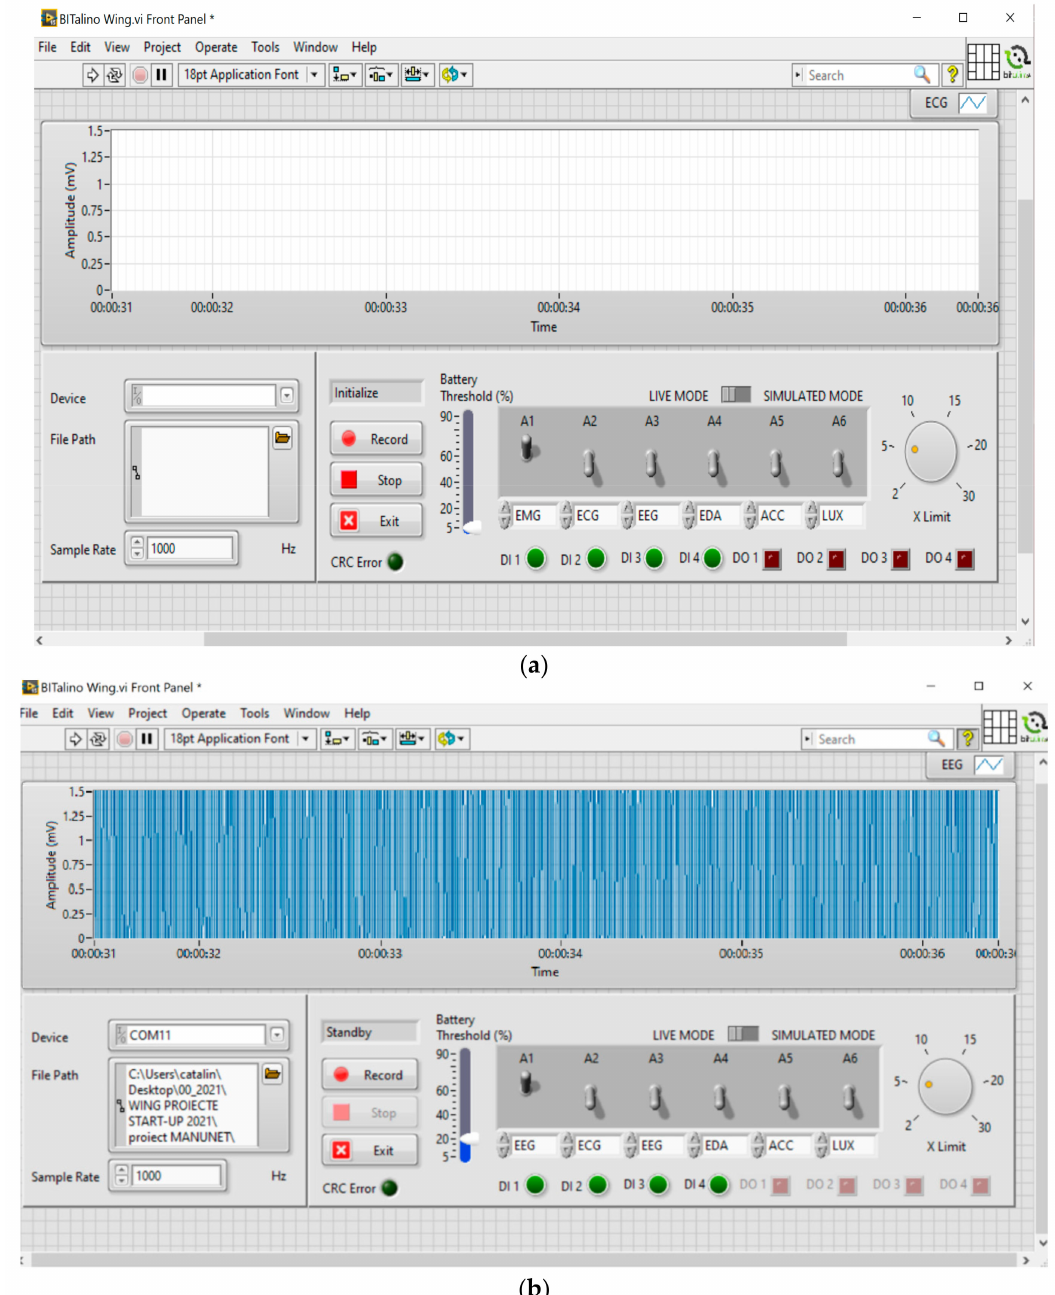
Figure 11. ( a ) GUI Software application developed for the acquisition of biomedical signals using Bitalino hardware; ( b ) the acquisition of EEG signals from the driver/passenger is